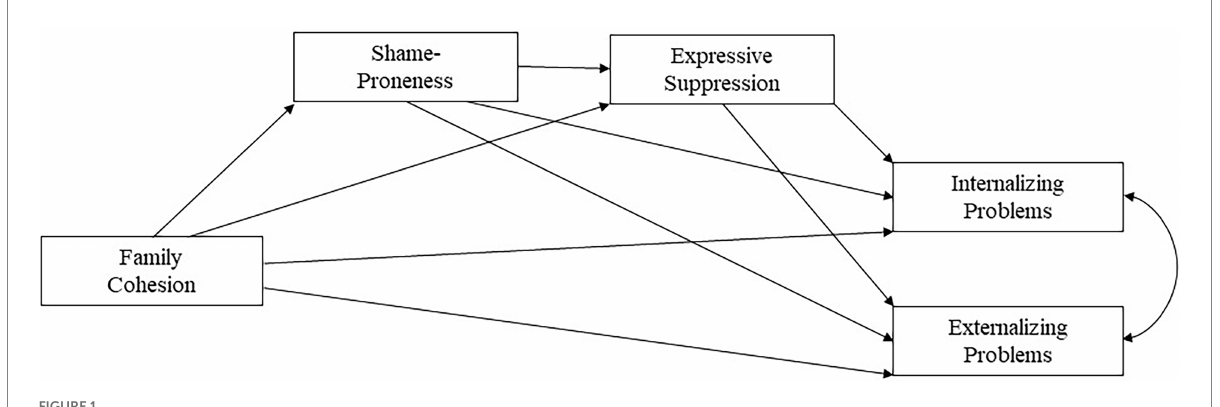
FIGURE 1 Theoretical model. Control variables are not